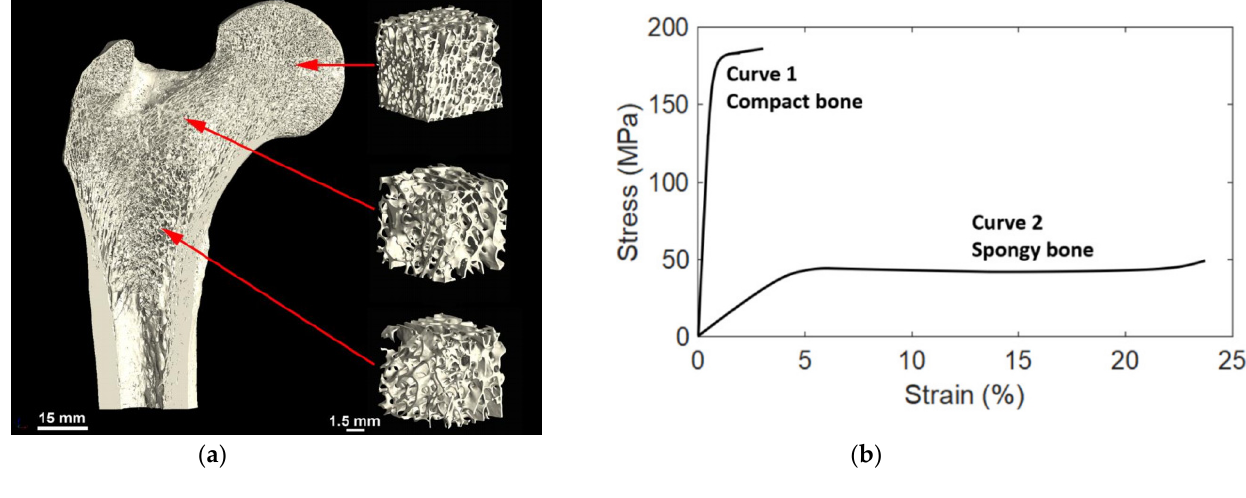
Figure 2. ( a ) Variation in the trabecular bone structure by location, in this example from the hu- man femur of a 26-year-old male. Reprinted with permission from ref. [56]. 2019, Elsevier Inc. ( b ) Typical stress-strain curves of compact (Cortical) and spongy (Trabecular) bones. Reprinted with permission from ref. [57]. 2021, MDPI.